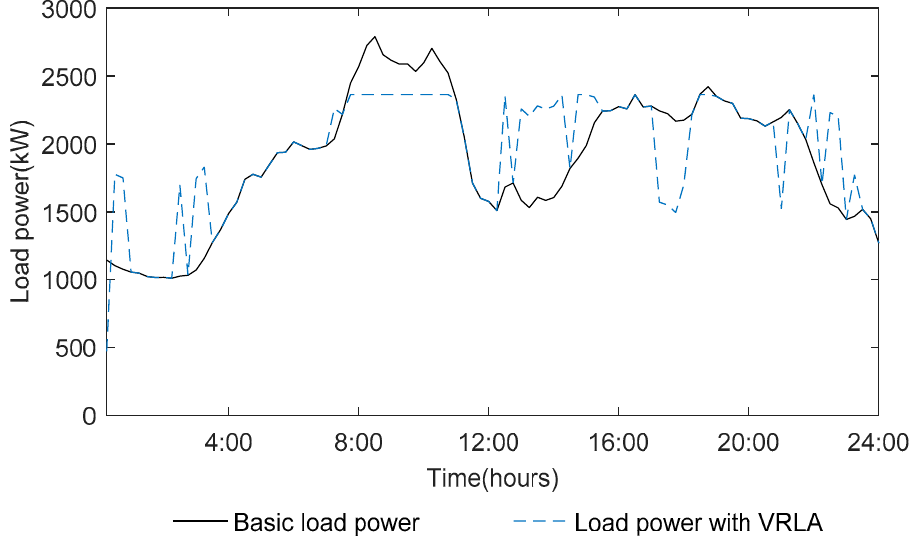
Figure 2. User load power with VRLA (Demand management).